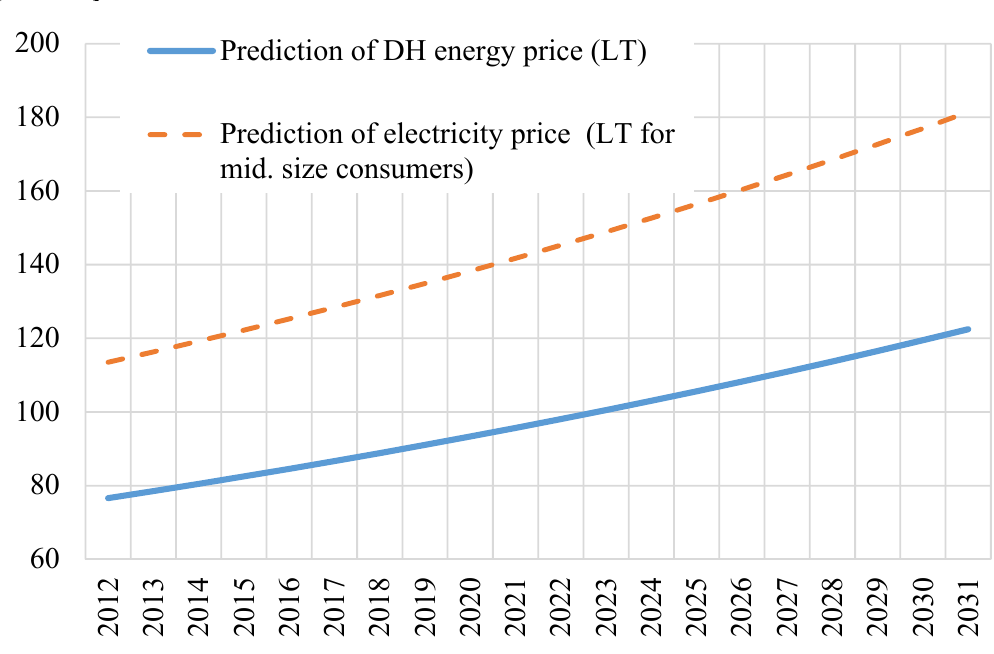
Figure 3. Prediction of district heating (DH) and electrical energy prices in Lithuania (according to historical average oil price growth—2.5%/year since